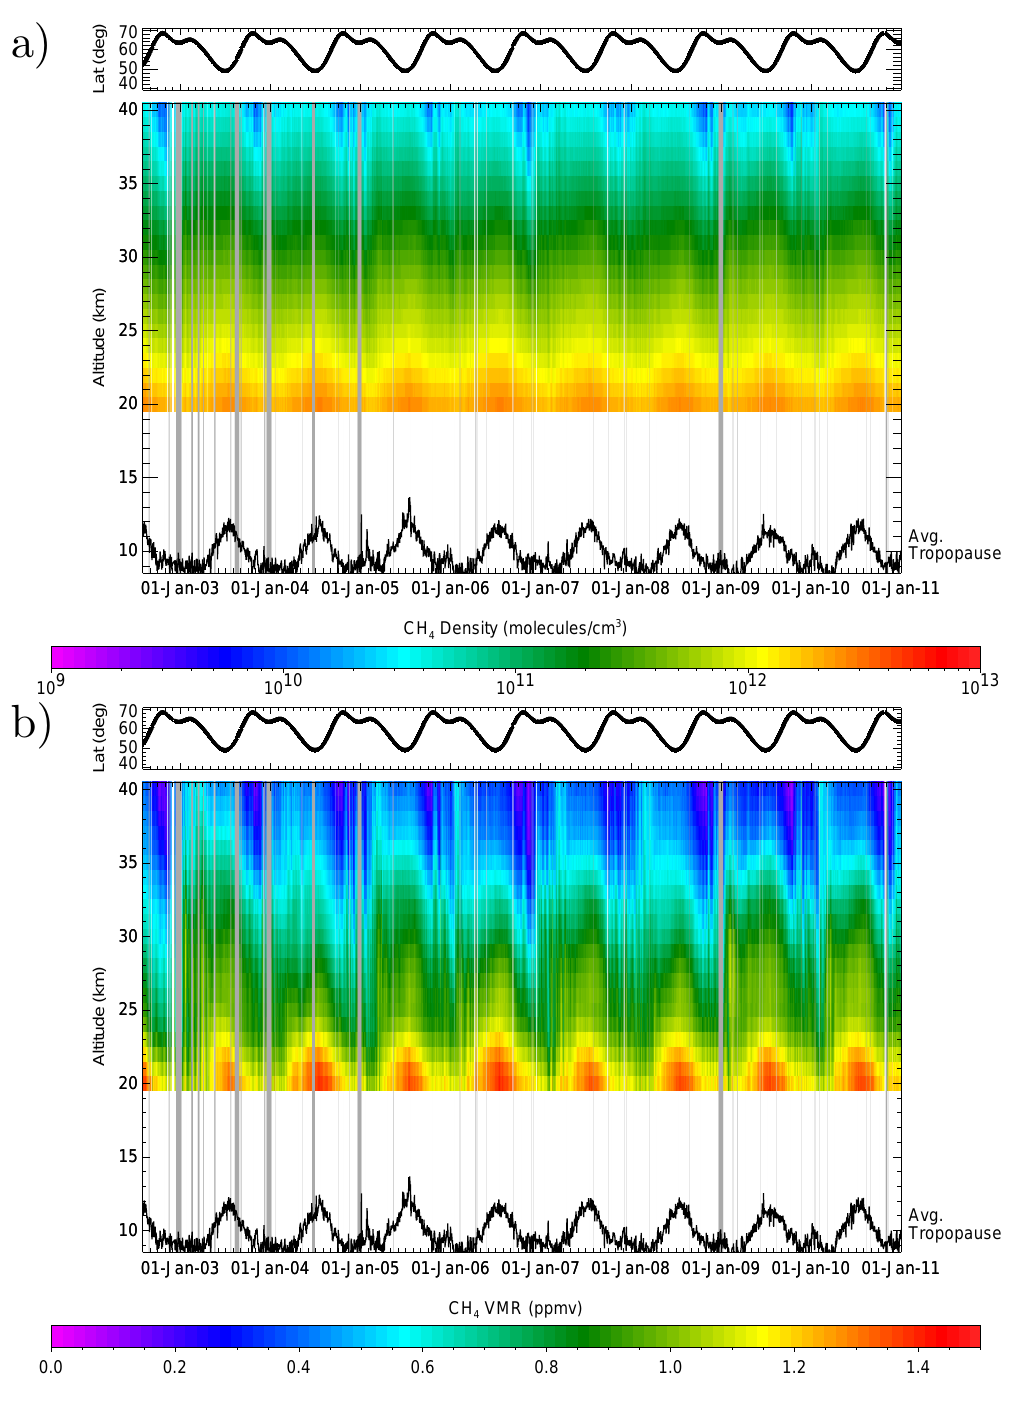
Fig. 4. Time series of daily averaged CH 4 profiles August 2002 – December 2010. (a) Retrieved number densities. (b) Volume mixing ratios (VMRs) derived from combination with ECMWF pressure and temperature data. In both sub-figures the latitudinal range covered by the SCIAMACHY measurements is indicated on the top. The black curve on the bottom shows the average tropopause height, derived from collocated ECMWF data. The vertical grey bars mask out periods of reduced SCIAMACHY data quality (e.g. due to instrument switch-offs or decontamination